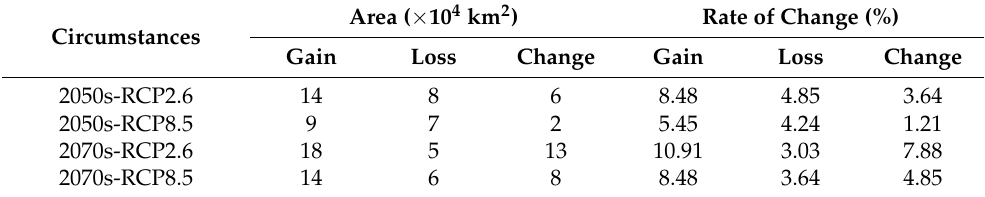
Table 5. Spatial variations in suitable habitat for Q. spinosa in different periods.